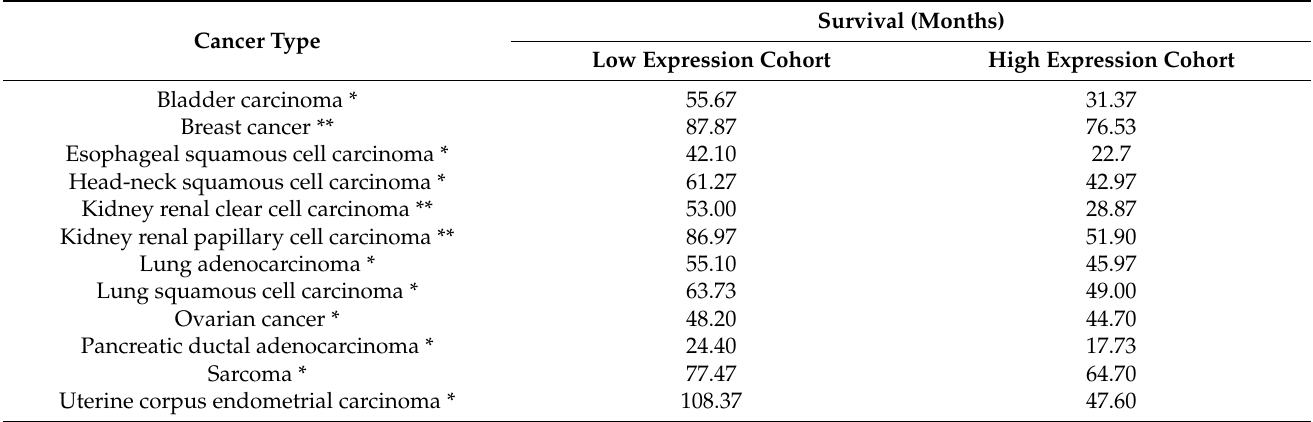
Table 1. Relationship between IGFL2-AS1 expression level and prognosis of different types of cancer in the Kaplan-Meier Plotter.